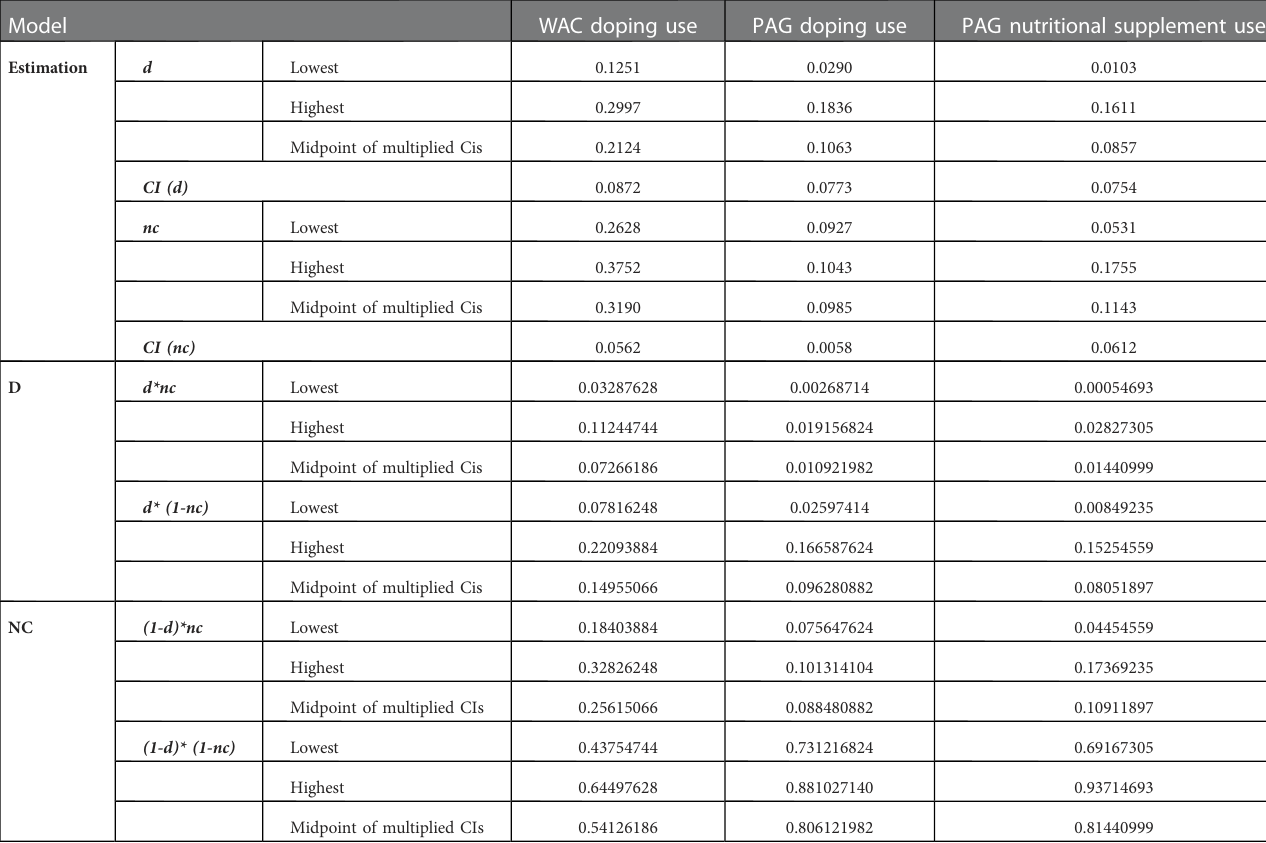
In Figure 3 : Comparison of doping prevalence estimates for WCA and PAG between the two survey formats, and with literature evidence. Data extracted from Table 1 using the most relevant fi gure (i.e., elite level and current/last season/past 12 months) when multiple estimates are reported. In the fi gure legend ‘ ABP Blood doping WAC 2021 ’ should read as ‘ ABP Blood doping WCA 2011 ’ .